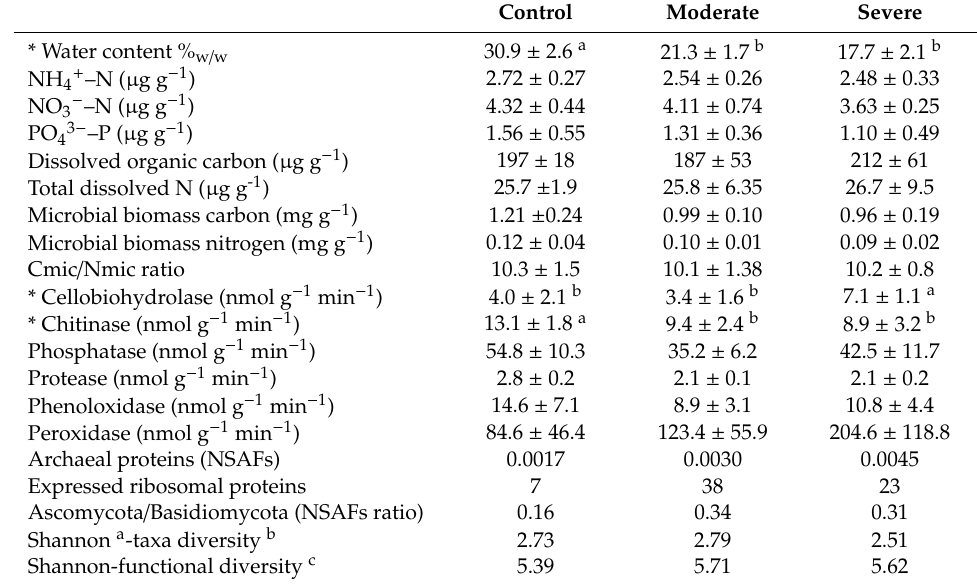
Table 1. Water content, physicochemical properties, microbial biomass, extracellular enzymes, and Shannon indices of soil microbial taxa and functional diversity. Data show mean and standard errors (n = 4); significant di ff erences according to Tukey’s multiple comparison test ( p < 0.05) are indicated with di ff erent lowercase letters (* marked on the corresponding soil